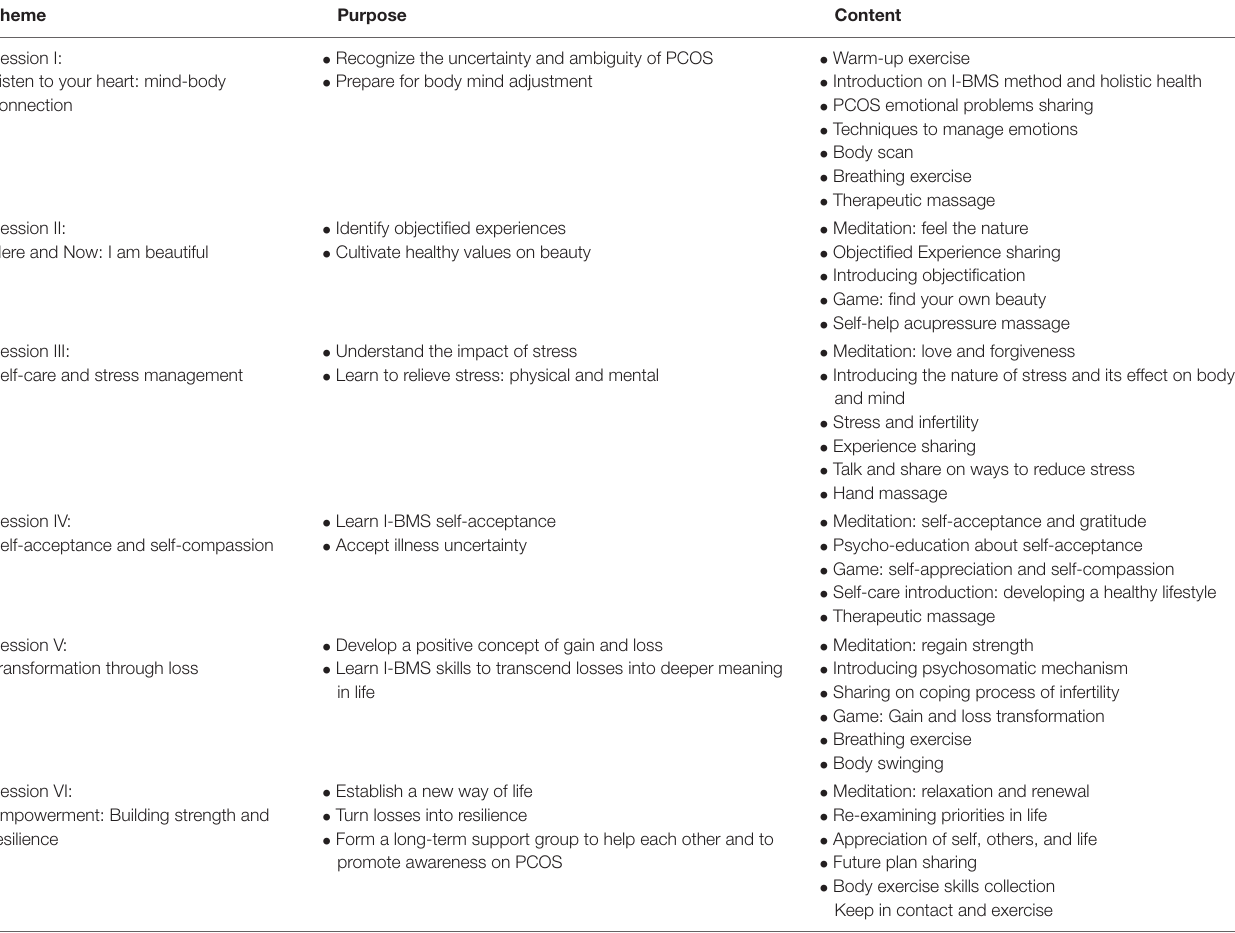
TABLE 1 | Session content of the Integrative Body-Mind-Spirit (I-BMS) group intervention for women with Polycystic Ovary Syndrome (PCOS). Theme Purpose